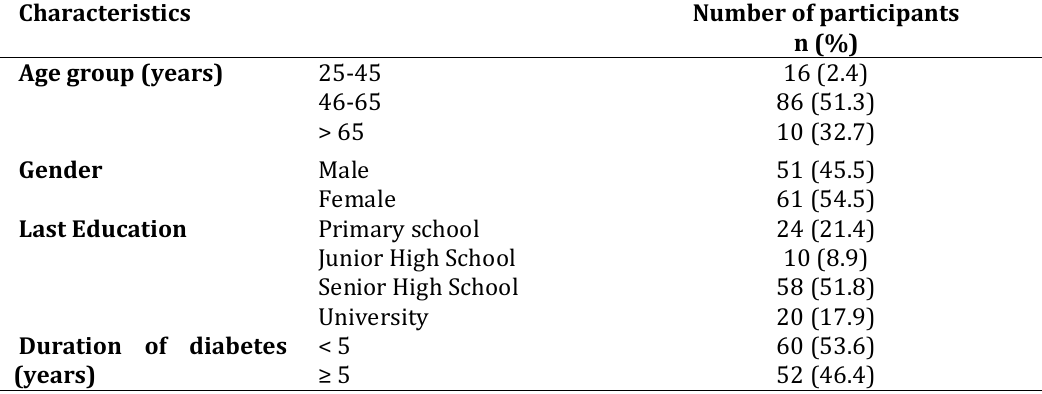
General and clinical characteristic of the study groups Characteristics